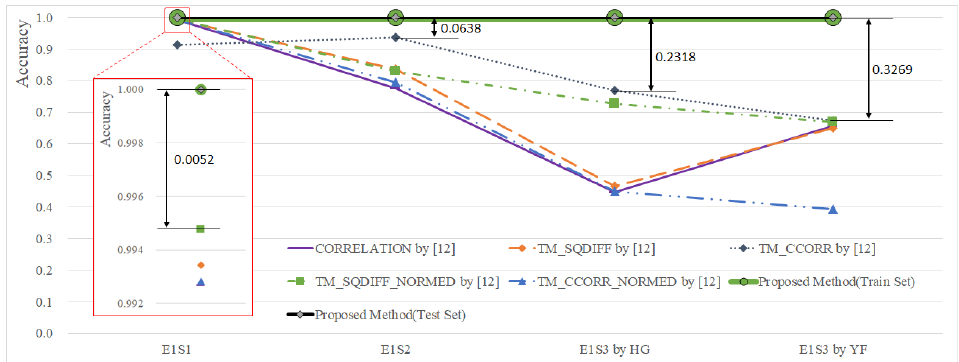
Figure 17. Classification performance (proposed method vs. existing method).